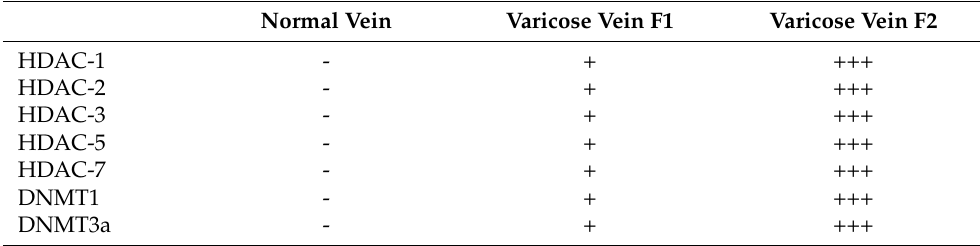
Table 1. Comparison of the expression of epigenetic factors HDACs and DNMTs in venous endothelial cells of normal veins with normal venous flow and in the endothelial cells of varicose veins with different levels of blood reflux. Normal Vein Varicose Vein F1 Varicose Vein F2 HDAC-1 - + +++